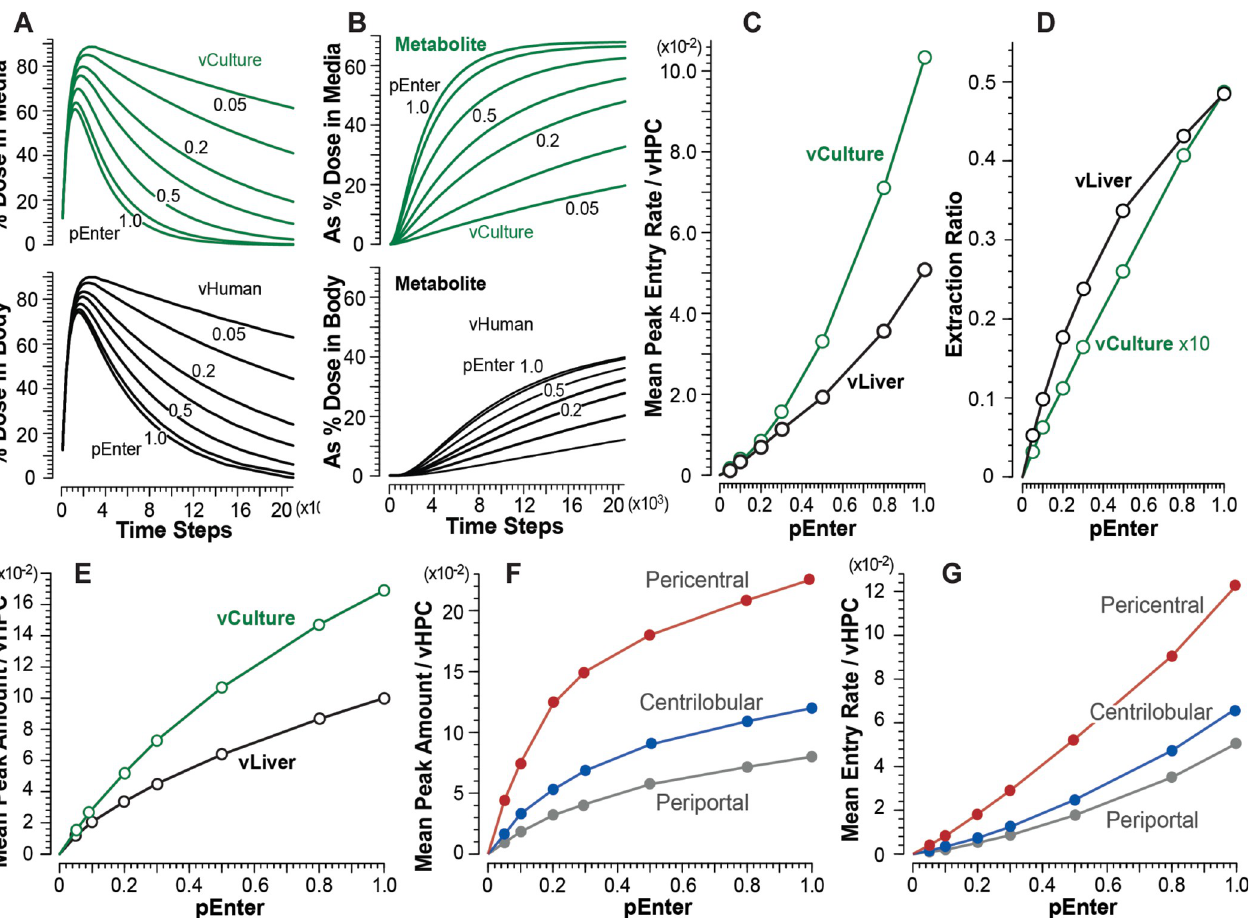
Fig 9. Results from vCulture and vHuman experiments using vC4. (A) Temporal measures of percent Dose in Body (top) and Media (bottom) for each pEnter . (B) Amount of Metabolite in Body (top) and Media (bottom) as percent of Dose for each pEnter . (C) Correlations between mean peak Entry rates and pEnter . (D) Correlations between mean plateau values of Extraction Ratio and pEnter . (E) Correlations between systemwide mean peak amounts of vC4 (objects) per vHPCs and pEnter . (F) Correlations between mean peak amounts of vC4 per vHPCs within the three vLiver bands and pEnter . (G) Correlations between mean peak Entry rates within the three bands and pEnter